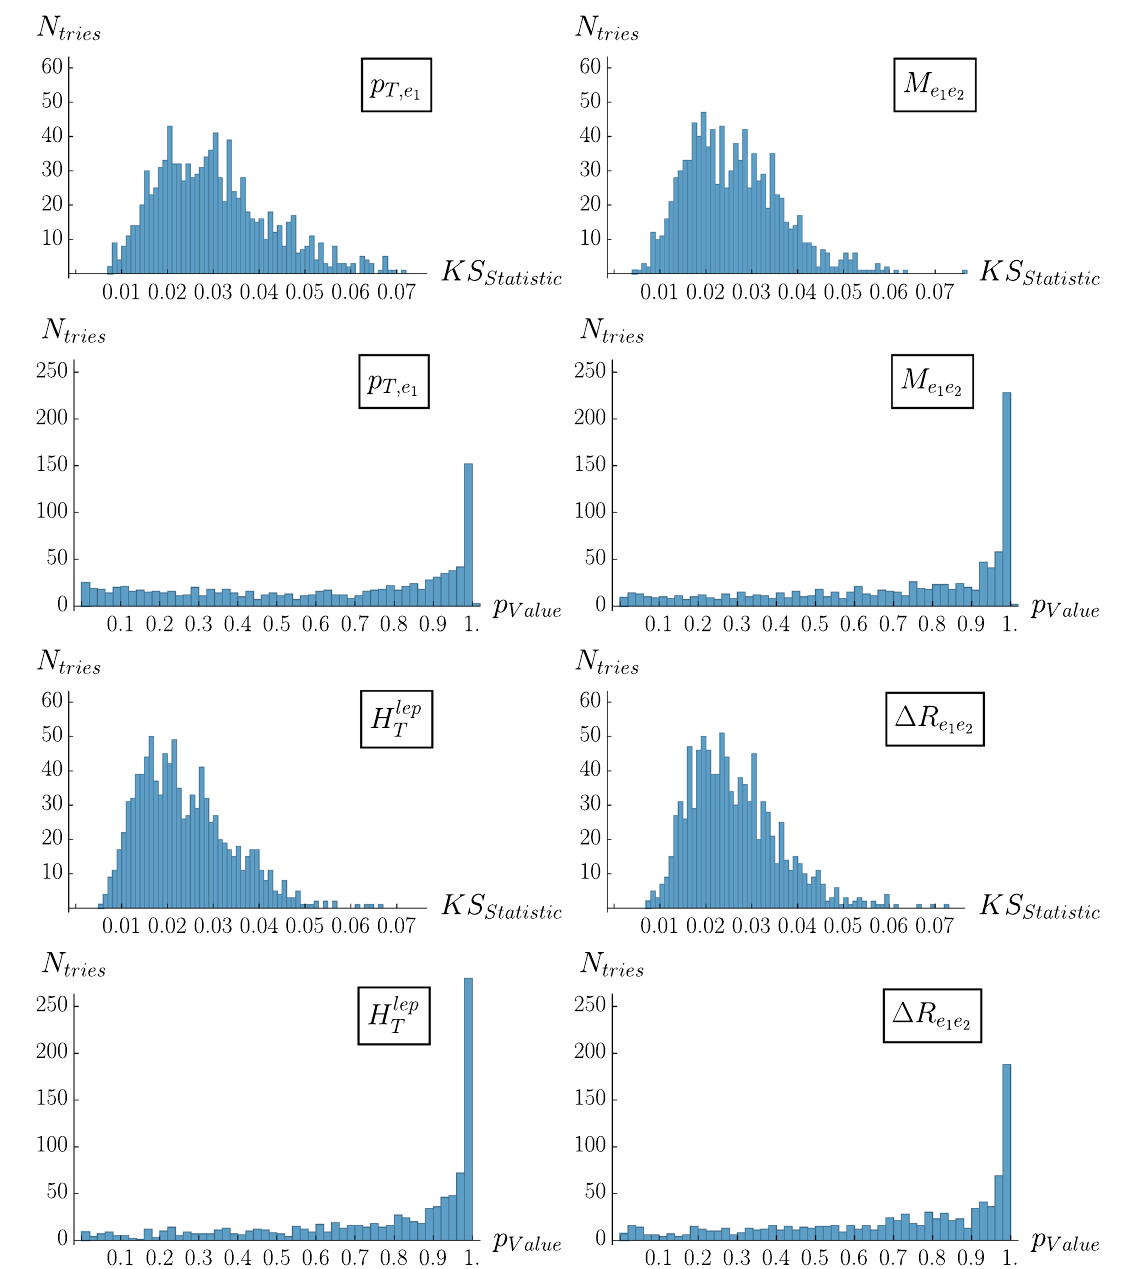
√ s = 13 TeV. Also , M e , H lep and (cid:12) R e for the LHC with of p T , e T 1 1 e 2 1 e 2 shown are the distributions of the corresponding p -values. The total number of N tries is set to 1000